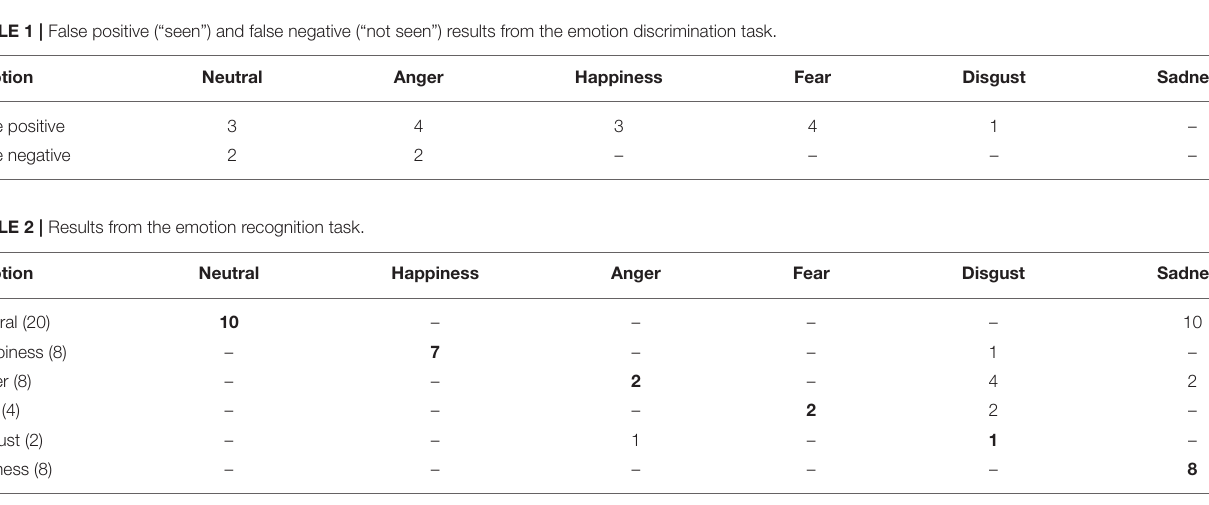
TABLE 1 | False positive (“seen”) and false negative (“not seen”) results from the emotion discrimination task. Emotion Neutral Anger Happiness Fear Disgust Sadness